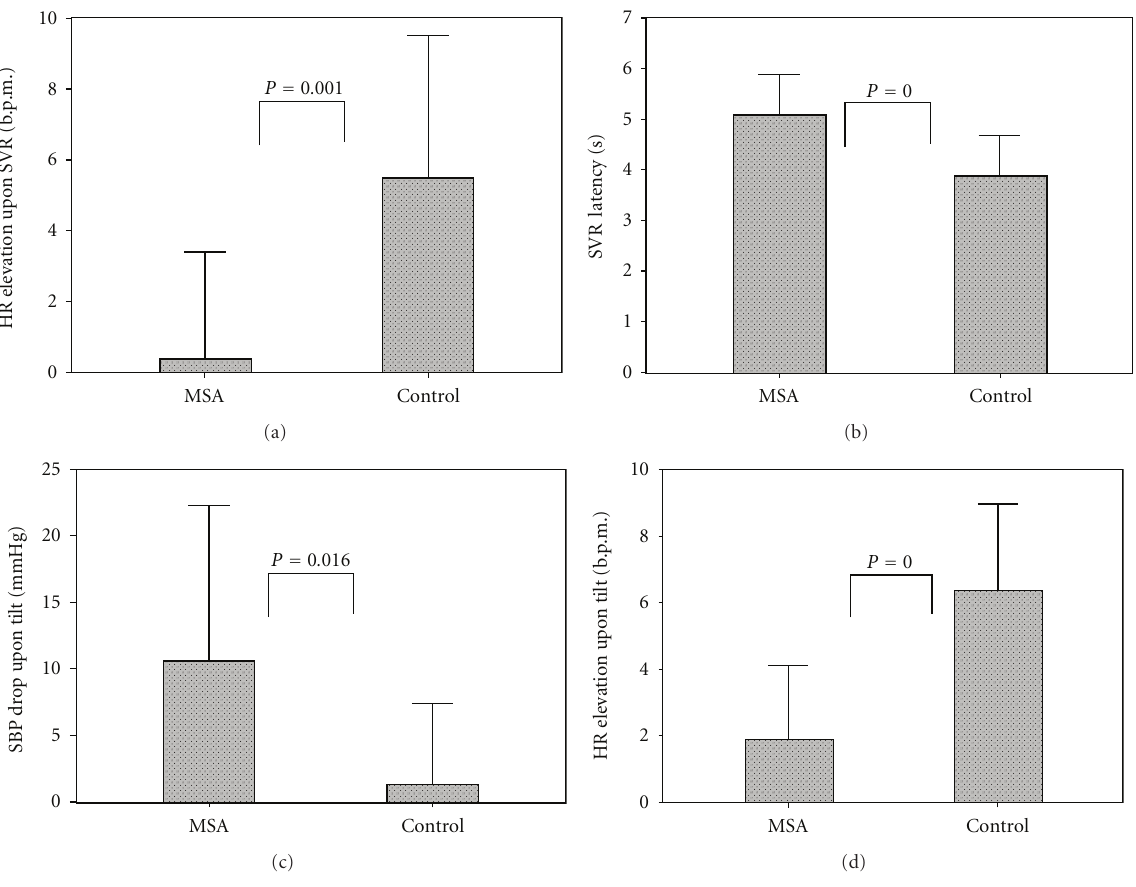
Figure 2: The comparisons of hemodynamic variables between MSA patients and healthy controls. Regarding SVR, MSA patients had (a) lower HR elevation and (b) a prolonged SVR latency. As for the tilt table study, MSA patients had (c) significant drop of SBP and (d) less HR elevation. Note: SVR: sympathetic vasomotor response; MSA: multiple system atrophy; HR: heart rate; SBP: systolic blood